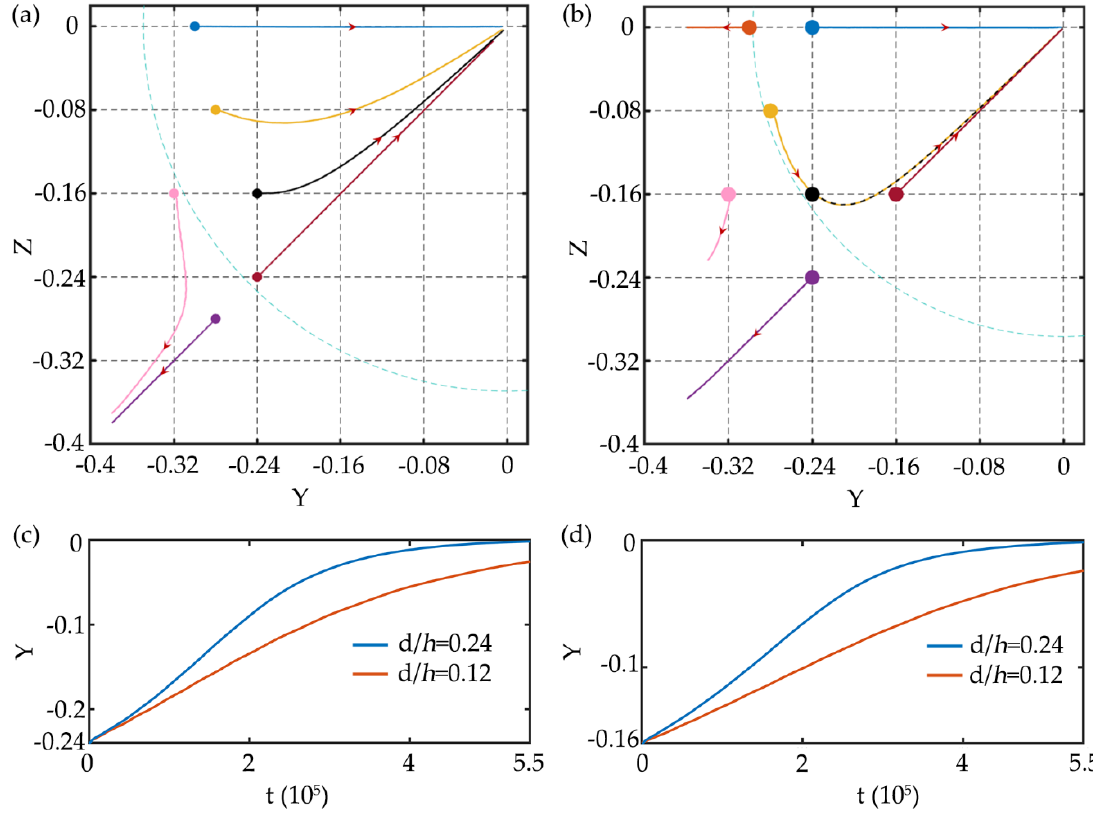
Figure 9. The migration trajectories of the particles with ( a ) d / h = 0.12 and ( b ) d / h = 0.24 at different initial positions of the cross-section under Re = 1.0 and Wi = 0.3. The maximum simulation time for ( a ) and ( b ) is 1,200,000 dimensionless time units. Time history of the longitudinal migration of particles at the initial positions ( c ) ( − 0.24, 0) and ( d ) ( − 0.16, − 0.16).